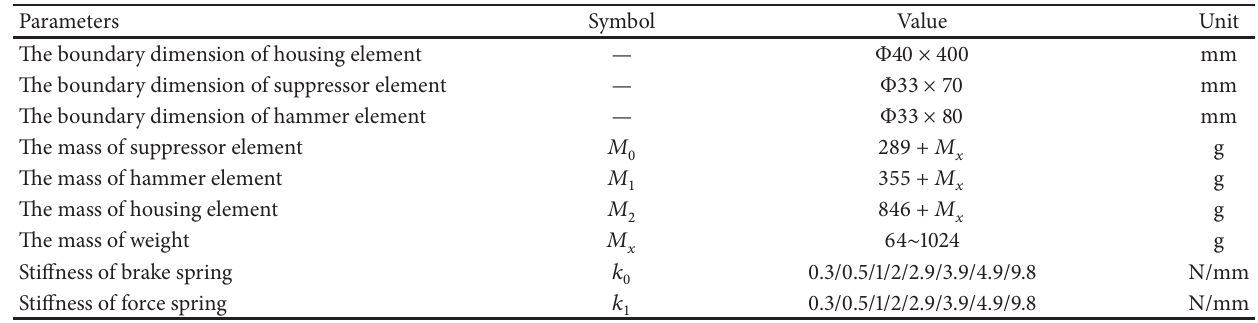
Table 1: Parameters of impact test